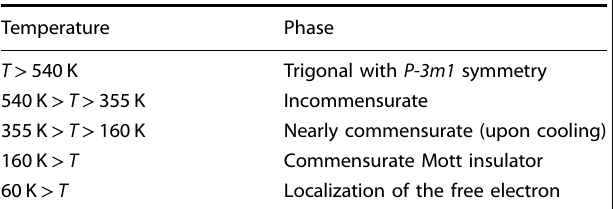
Table 1. 1T-TaS 2 phase